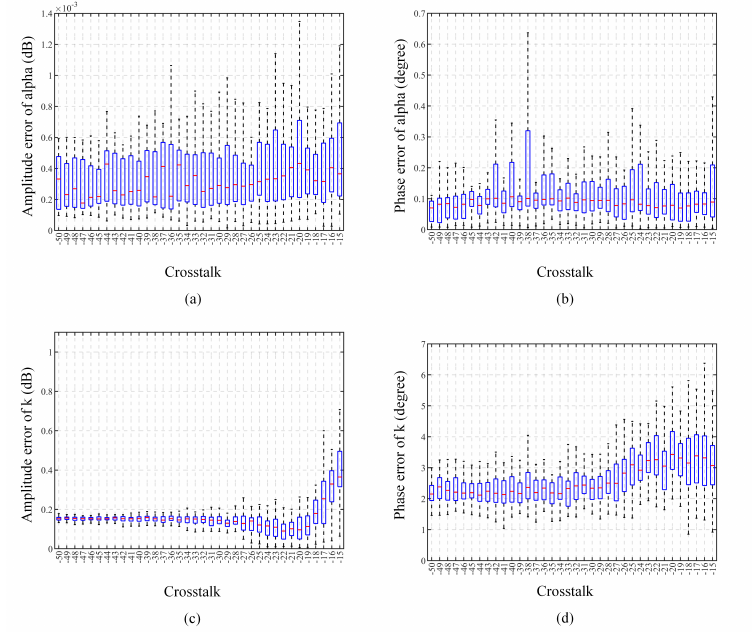
Figure 12. Effect of different crosstalk levels on the channel imbalance estimation: ( a , b ) amplitude and phase errors of α ; ( c , d ) amplitude and phase errors of k . The standard boxplot notation is used (lower/upper hinges—first/third quartiles; whiskers extend from the hinges to the largest/lowest values no further than 1.5 × interquartile